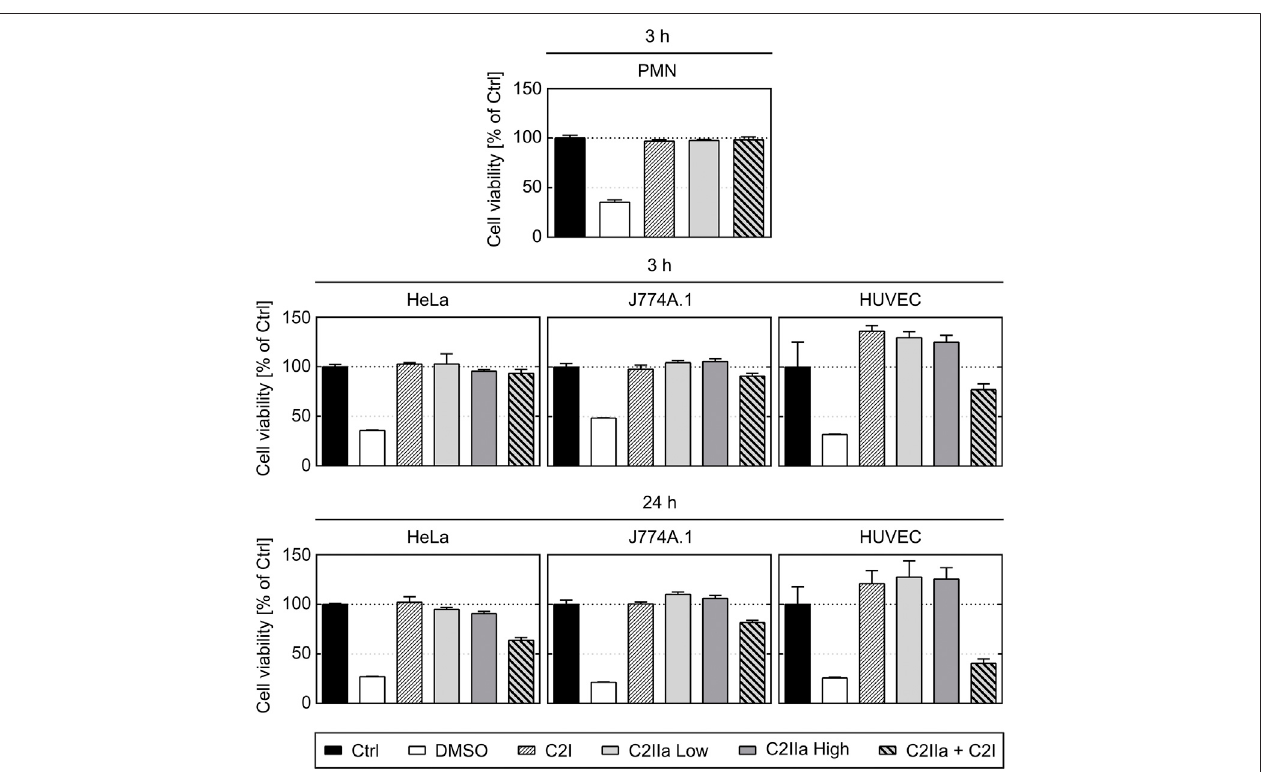
FIGURE 5 | Effectof complete C2 toxin and its single components C2IIa and C2I on the viability ofprimary human PMNs and on HeLa, HUVEC and J774A.1 cells. Relative viability (% of control) of different cell types after 3 and 24 h incubation (37 ° C) with DMSO (20%), C2I (1 μ g/ml), C2IIa Low (2 μ g/ml), C2IIa High (5 μ g/ml),